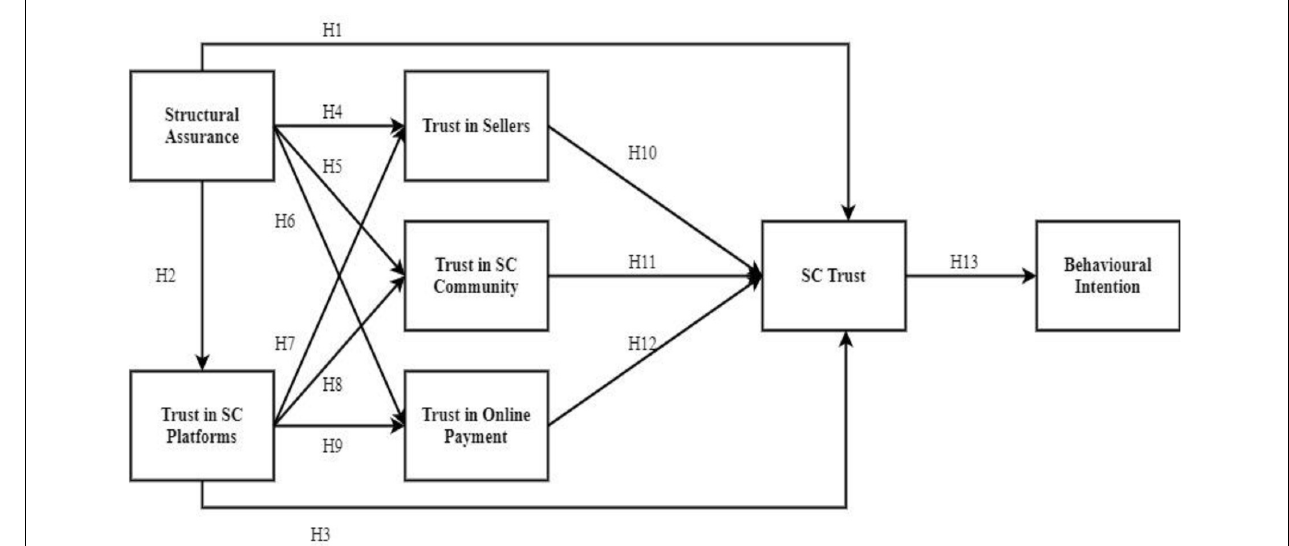
FIGURE 3 | Research